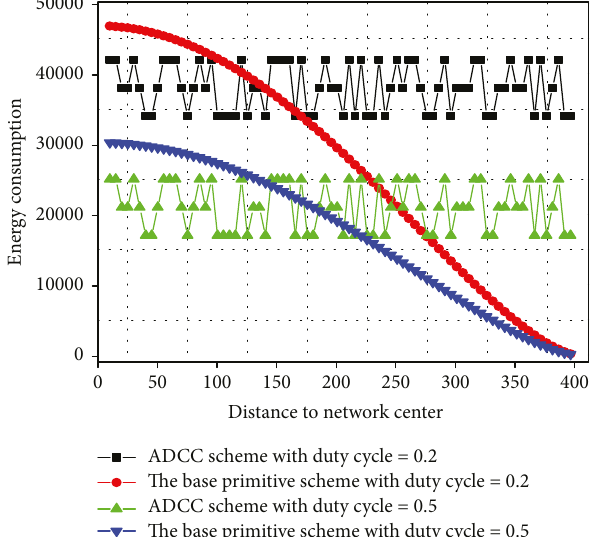
Figure 17: The total energy consumption of nodes in di ff erent